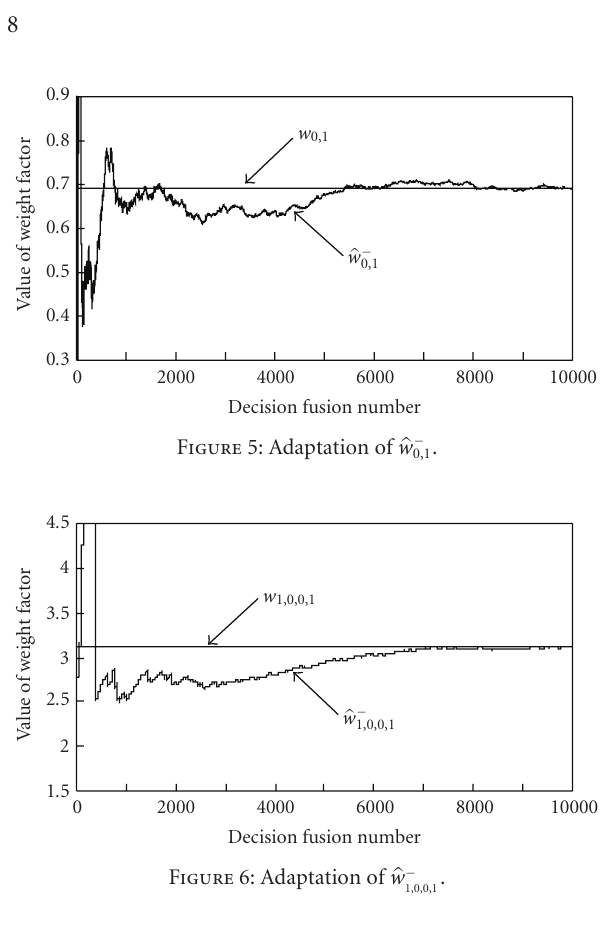
Figure 6: Adaptation of (cid:18) w −